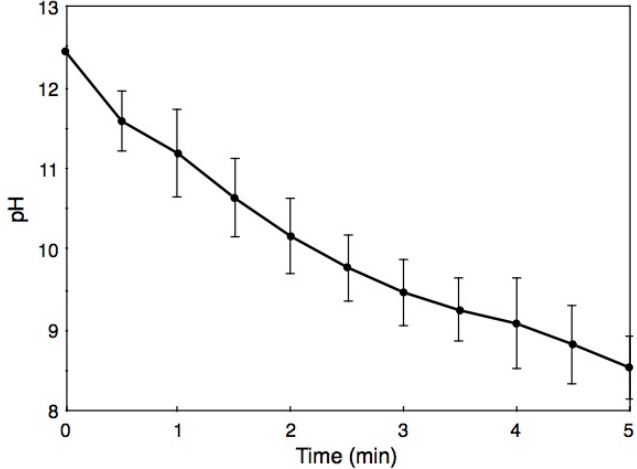
Figure 5. Changes of pH on back skin of hairless rats after spraying with BiSCaO Water. Values are plotted as mean ± SD ( n = 4).